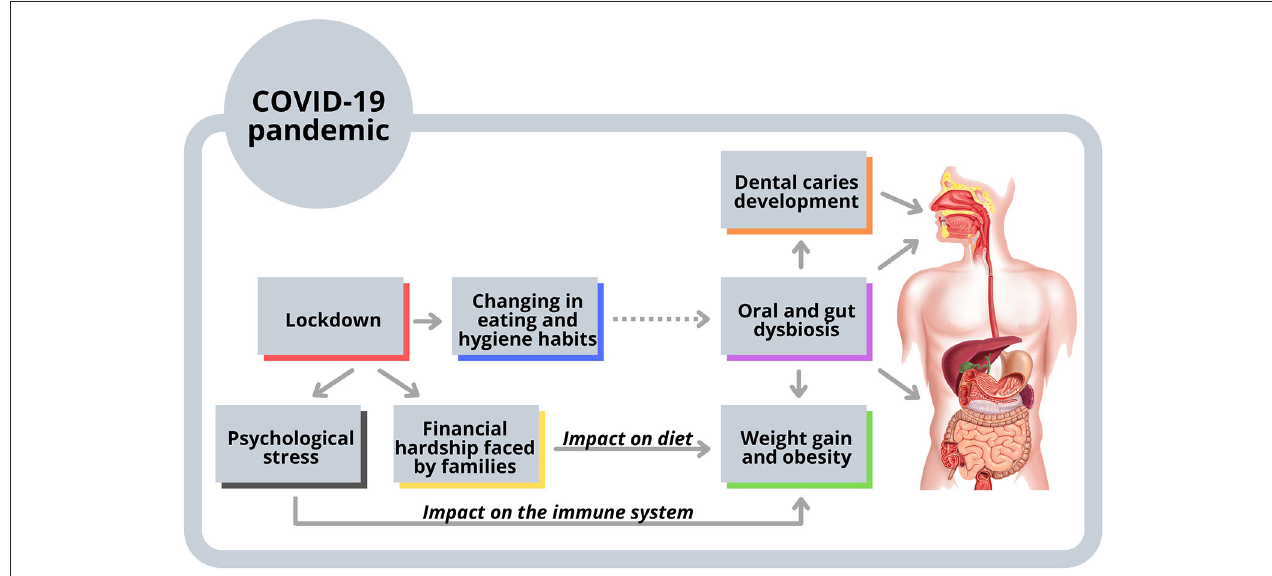
FIGURE 1 | Possible interplay among oral and gut microbiome, dental caries, and obesity. The consumption of unhealthy food for children increased during the confinement of COVID-19 pandemic. Eating and hygiene habits were also changed and could affect the oral microbiome. As oral bacteria are frequently swallowed with food and beverages during the digestion process, they can reach the gastrointestinal tract influencing the gut dysbiosis and weight gain. Also, factors linked to the lockdown, such as psychological stress and financial hardship faced by families, could have impacted the immune system, eating habits, and